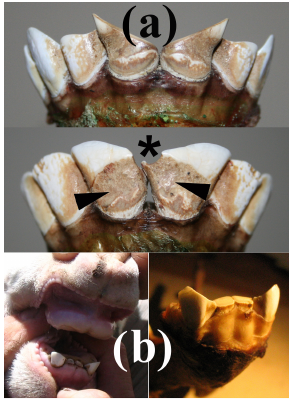
Figure 1. (a) Typical early fluorosis lesions in deer due to the Puyehue–Cordón Caulle volcanic eruption. (b) Typical fluorosis lesions in livestock due to the Puyehue–Cordón Caulle volcanic eruption. The new I1 are already completely worn down as the I2 emerge.